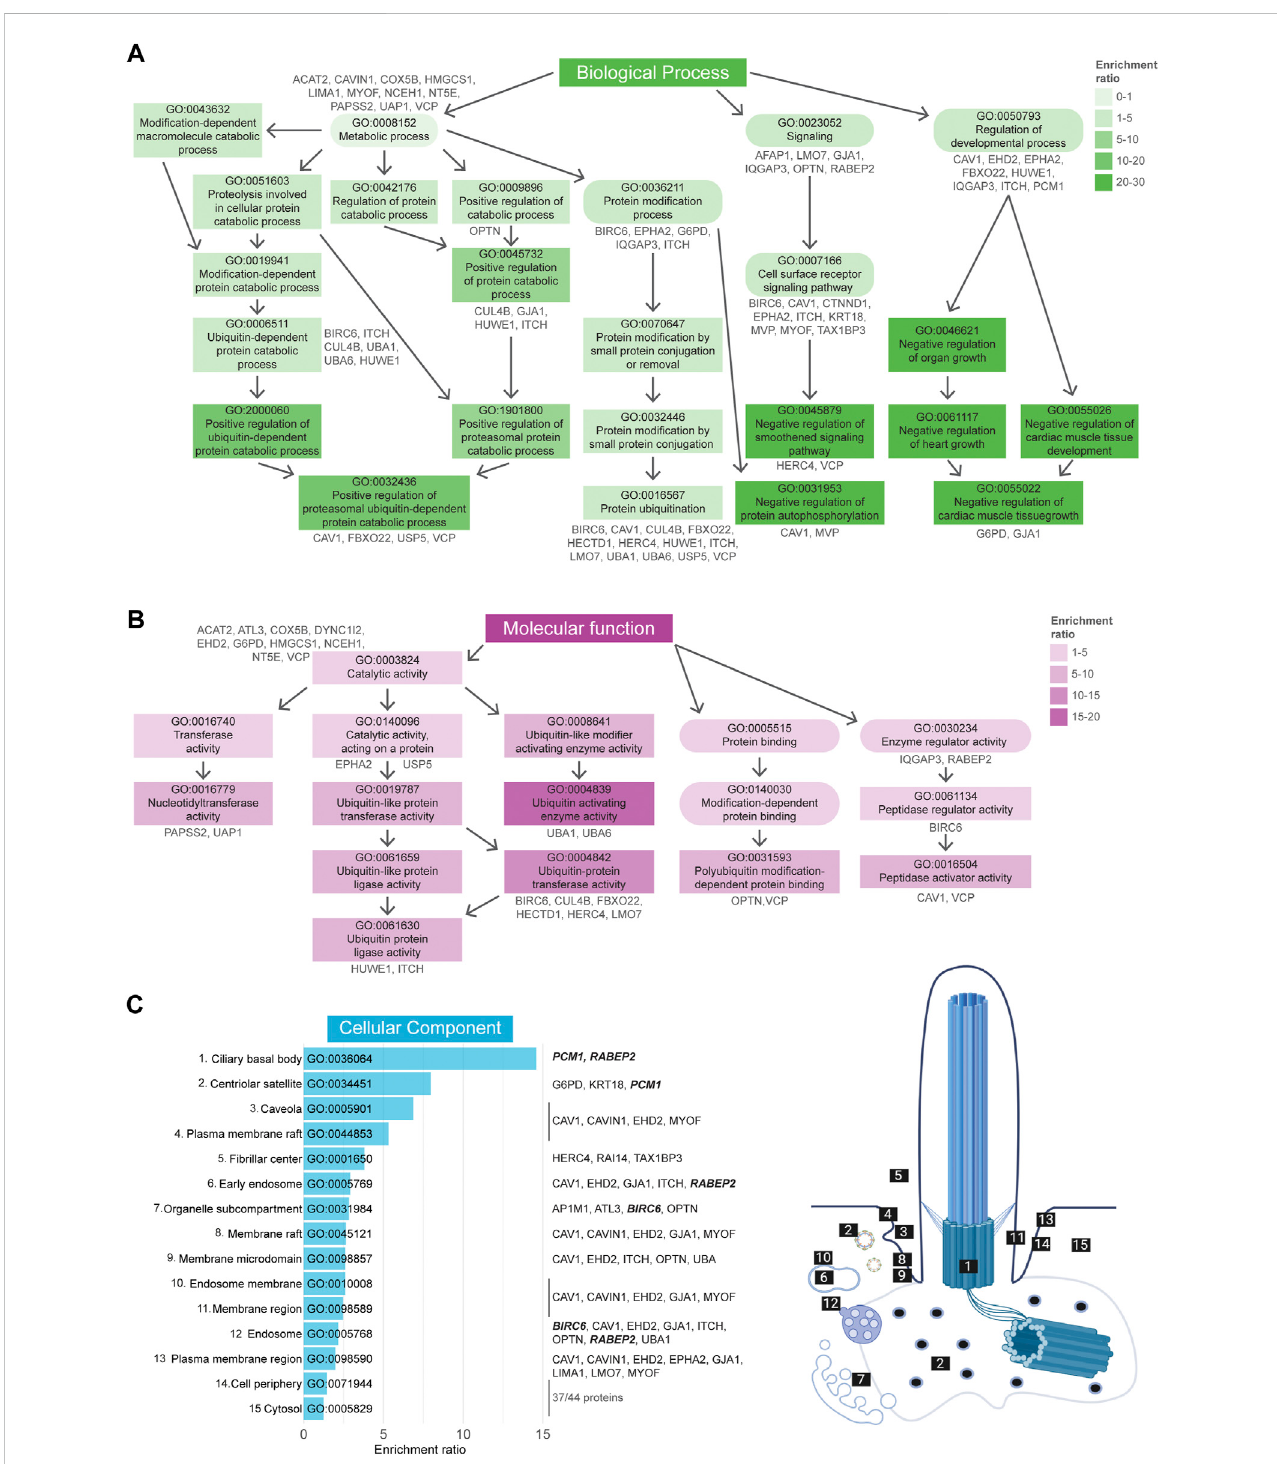
GeneOntologyenrichmentanalysisofUAPdataset. (A) GOtermenrichmentforbiologicalprocesses(BP)coloredbytheirenrichmentratio.The19most enriched terms(Fisher ’ sexact testvalue ≤ 1.5E-3)aredisplayed (square) alongwith supporting GO terms(circle).Arrows indicate theassociated termsand the genes per term are indicated in grey. All upstream terms also include the genes from the related downstream terms. (B) GO term enrichment analysis for molecular functions (MF) for which all 13 signi fi cantly enriched MF terms (Fisher ’ s exact test value ≤ 0.05) are displayed as in (A) . (C) All 15 signi fi cantly enrichedterms(Fisher ’ sexacttestvalue ≤ 0.05)ofthecellularcomponents(CC)GOtermenrichmentanalysisaredisplayed,orderedbytheirenrichmentratio. The cellular position of these terms and their related proteins are indicated on the right. The term “ Fibrillar center ” refers to the nuclear region involved in transcription of ribosomal RNA, however the genes associated here with this term were also shown to localize to the cilia (dashed line). The same applied for the terms “ Cell periphery ” and “ Cytosol ” , for which the related genes were not indicated, as there were too many to clearly display. Proteins indicated in bold italic letters were shared hits between UBD-PL and UAP. Non-etheless, a complete list of proteins can be found in Supplementary Table